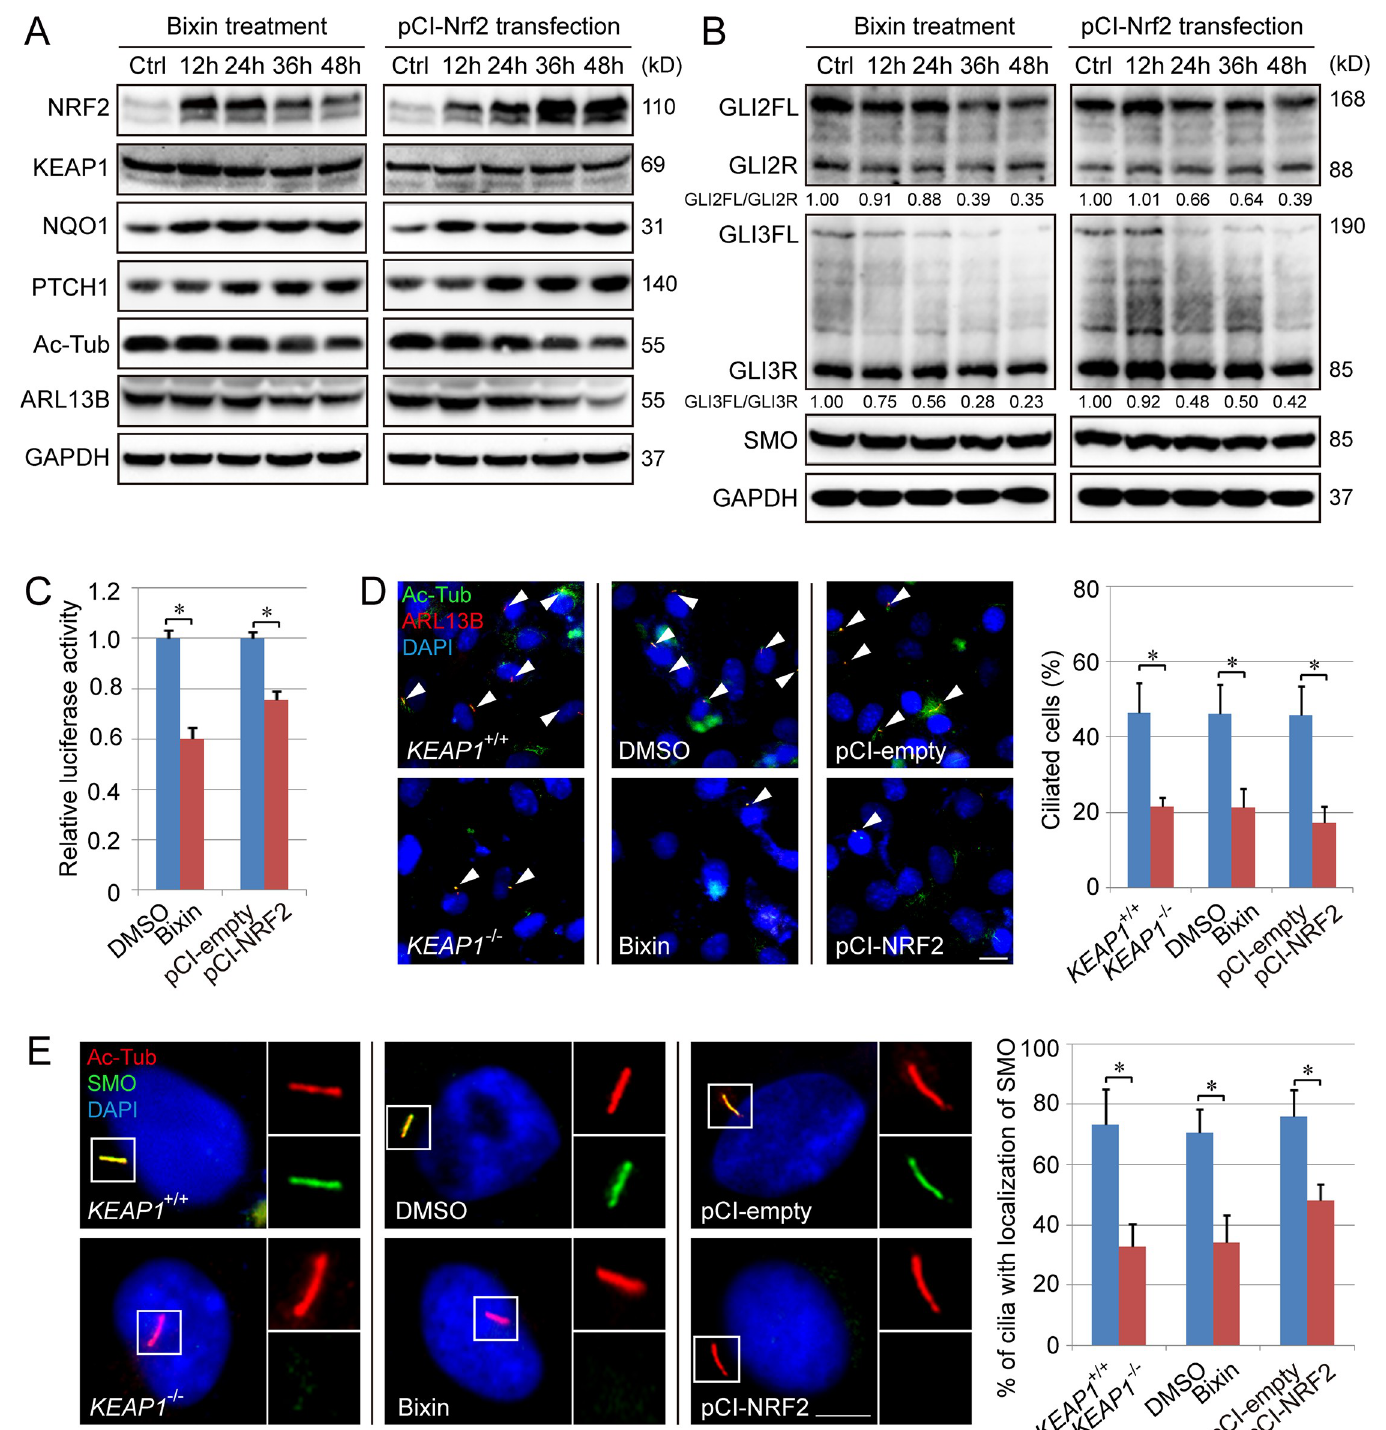
Fig 2. NRF2 negatively regulates Hh signaling, ciliogenesis, and ciliary translocation of SMO. (A–B) H1299 cells were treated with bixin (40 μ M) or transfected with pCI-NRF2 vector for 0, 12, 24, 36, or 48 h and subjected to immunoblot analysis of key Hh and ciliary proteins. (C) GLI luciferase assay in H1299 cells treated with bixin or vector transfection for 48 h. (D–E) KEAP1 − / − , bixin-treated (40 μ M for 48 h), and pCI-NRF2–transfected (for 48 h) H1299 cells were subjected to IF analysis of (D) % ciliated cells or (E) colocalization of Ac-Tub (green) and SMO (red) (D: scale bar = 10 μ m; E: scale bar = 5 μ m, n = 150). Relative quantification of immunoblot results is shown in S3A and S3B Fig. Results are expressed as mean ± SD. A t test was used to compare the various groups, and p < 0.05 was considered statistically significant. � p < 0.05 compared between the two groups. Ac-Tub, acetylated tubulin; ARL13B, ADP-ribosylation factor-like protein 13B; GAPDH, glyceraldehyde-3-phosphate